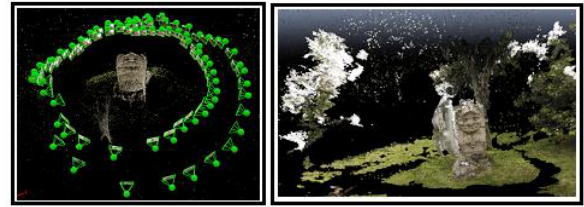
Figure 10. Position of the photographs (left), result of the generation of the 3D model (right).